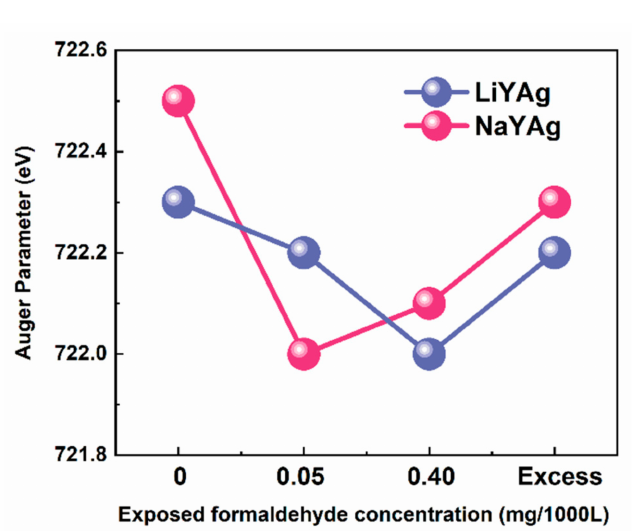
Figure 6. Auger parameter of Ag MNN in LiYAg and NaYAg before and after exposing in different formaldehyde-content